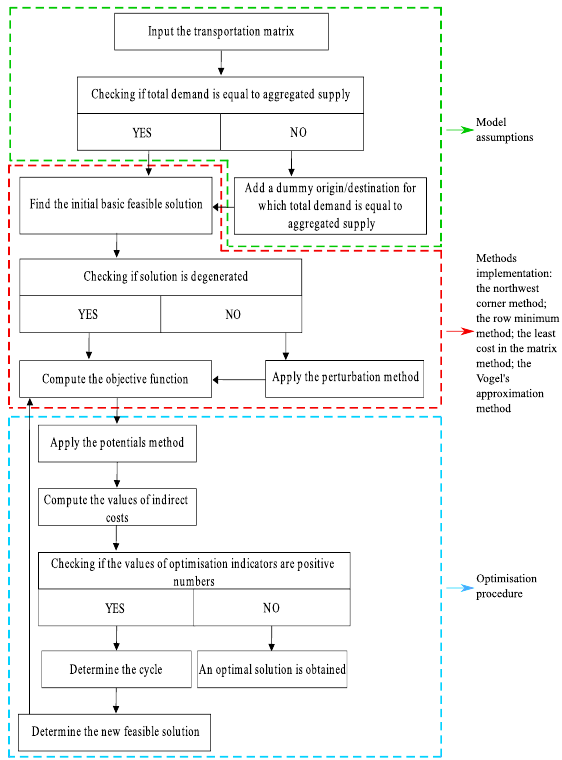
Figure 1. Flowchart of transportation